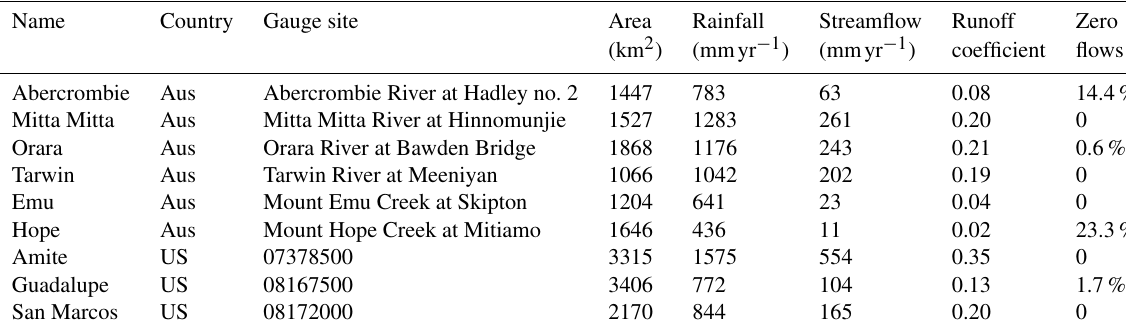
Table 2. Basic catchment characteristics